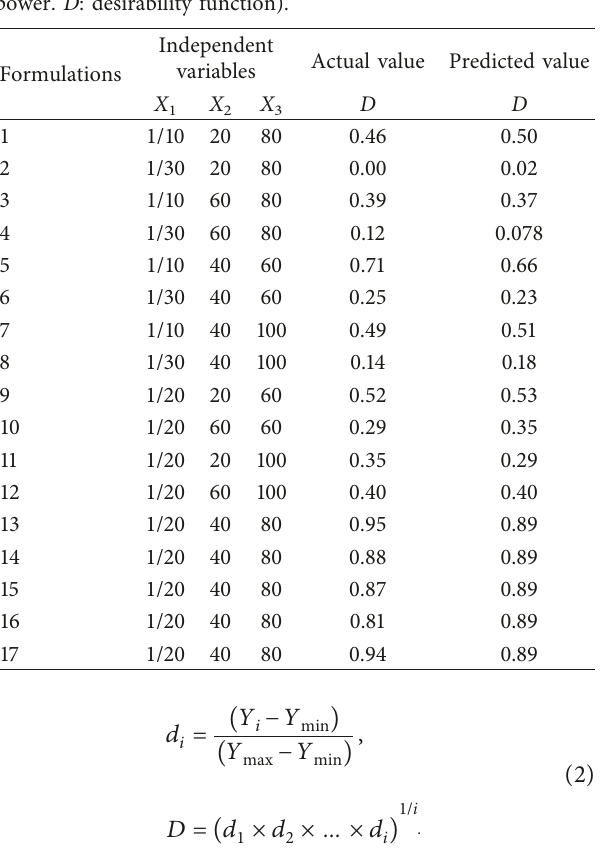
Table 4: Observed response in the Box-Behnken design for op- timization of C. songaricum extraction formulations with predicted values generated by Design-Expert software (three variables: X 1 : material-to-solvent ratio, X 2 : ultrasonic time, and X 3 : ultrasonic power. D : desirability function).